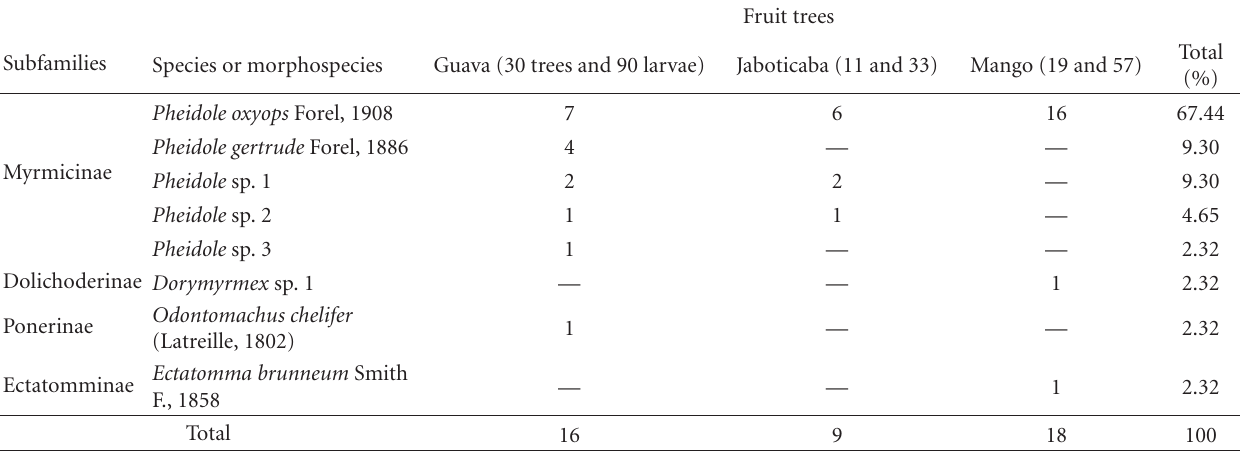
Table 1: Number and total percentage of larvae removed by ants beneath the crowns of 60 trees of three species of fruit, in a grove of the Universidade Federal da Grande Dourados, during an experiment o ff ering groups of three larvae under each crown. Guava is Psidium guajava , jaboticaba Myrciaria jaboticaba , and mango Mangifera indica